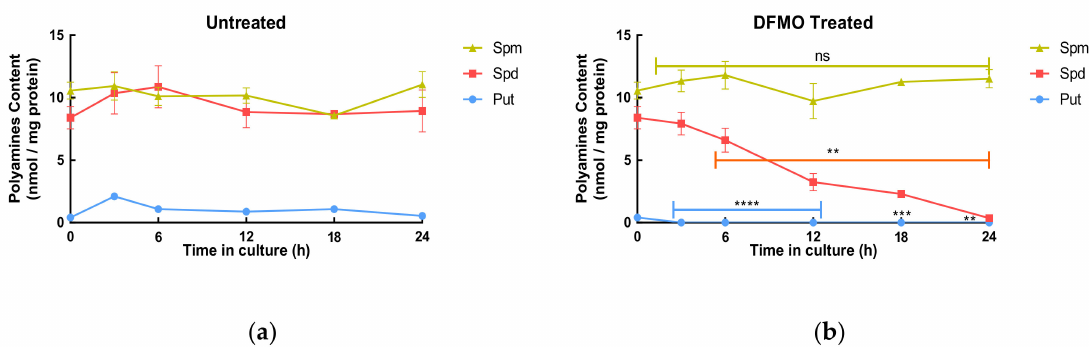
Figure 2. Individual polyamine content in untreated (a) and DFMO-treated cells (b) . SW480 cells were seeded at 2.4 × 10 4 cell / cm 2 in duplicate on 6-cm-diameter dishes and grown for 48 h. Where indicated, cells were pre-treated with DFMO (5 mM) for 24 h. Subsequently, two dishes were harvested and this time was set as t = 0 h. All plates were harvested at the time indicated and polyamine content was determined by LC-MS. Values are mean ± SEM ( n = 3) with duplicates for each experiment. P : * < 0.05, ** < 0.01, *** < 0.001, **** < 0.0001, ns = not significant; compared to the respective untreated control.